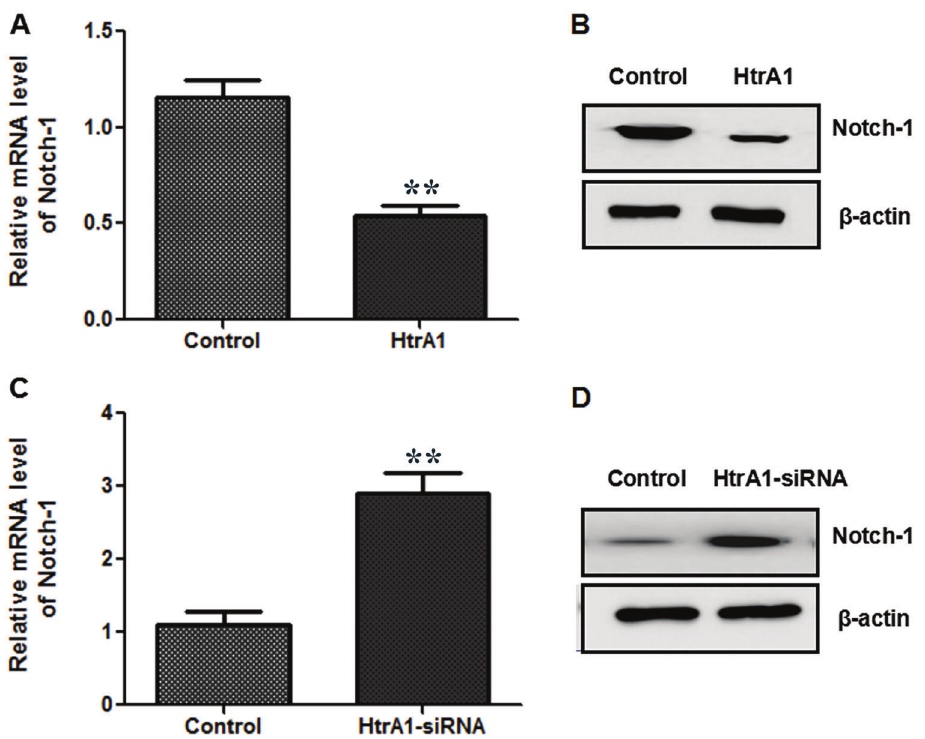
Figure 4. High temperature requirement factor A1 (HtrA1) regulated the expression of Notch-1 in pancreatic cancer cells. After transfection with pcDNA3.1-HtrA1 plasmids, the expression of Notch-1 was determined by real-time PCR ( A ) and western blot ( B ). Moreover, PANC-1 cells were transfected with HtrA1-siRNA, and then the Notch-1 transcripts ( C ) and protein levels ( D ) were measured by real-time PCR and western blot, respectively. Data are reported as means ± SD. **P o 0.01 ( t